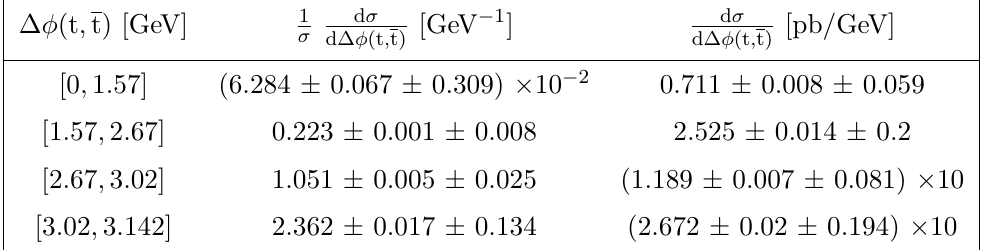
Table 28 . The measured di(cid:11)erential cross section and bin boundaries for each bin of the normalized and absolute measurements of the tt di(cid:11)erential cross section at particle level in the (cid:12)ducial phase space as a function of (cid:1) (cid:30) (t ; t) are tabulated.